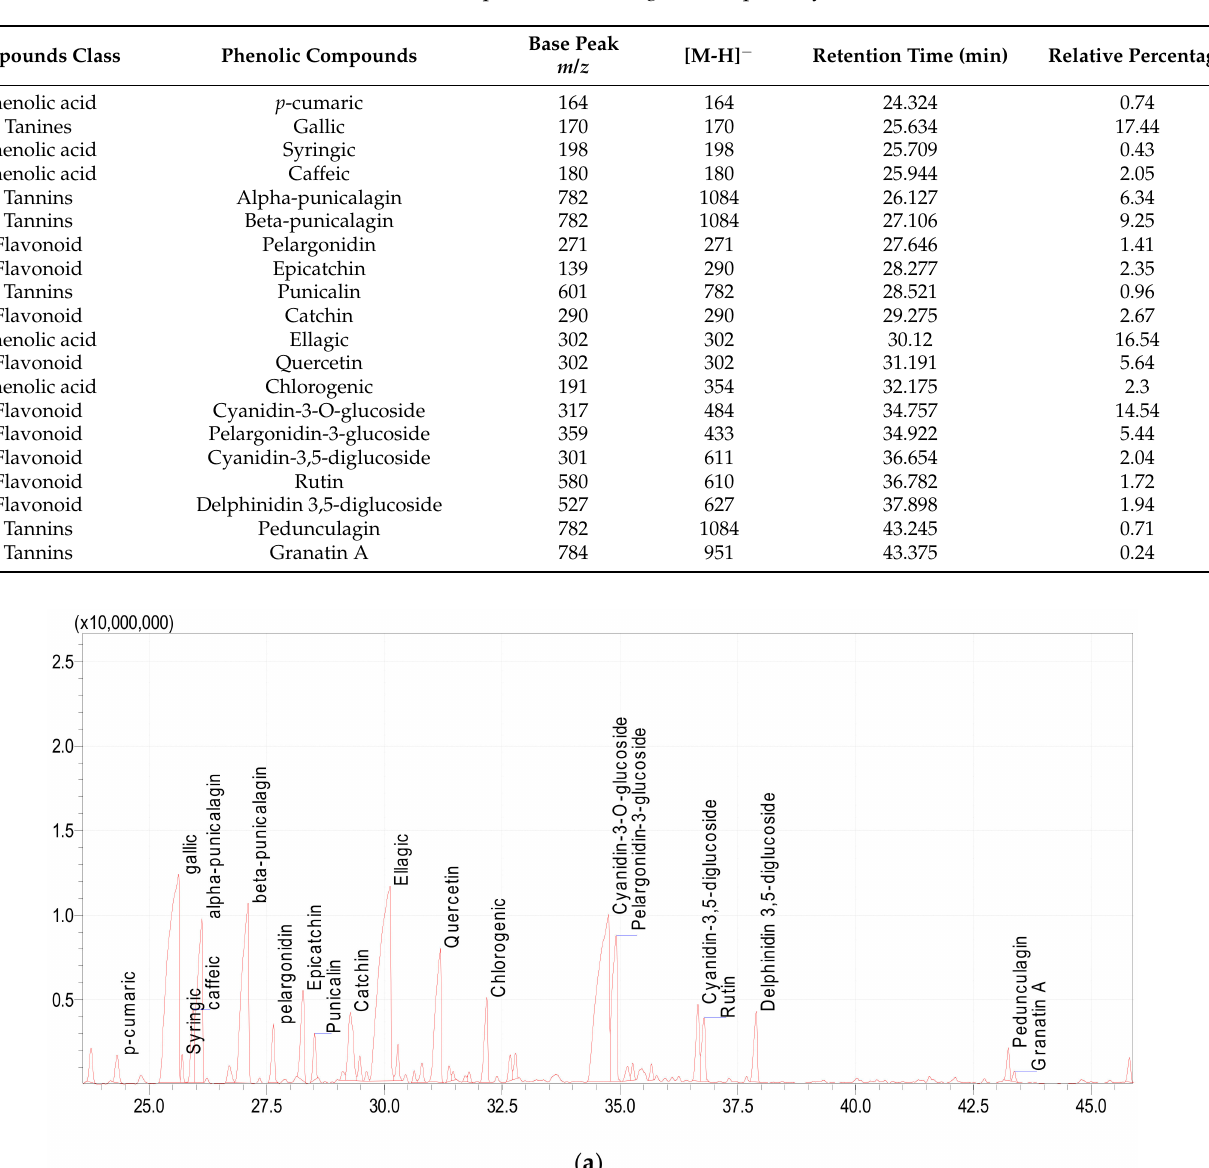
Table 7. Phenolic compounds in the P. granatum peels by LC-MS/MS.